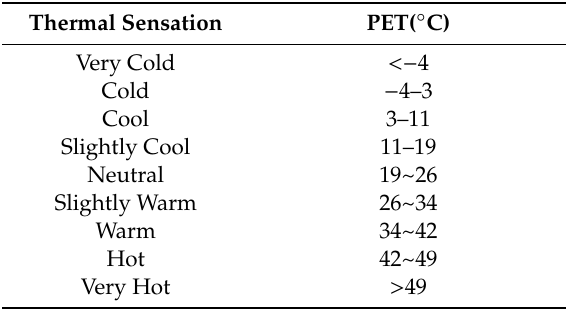
Table 6. The distribution of humans’ thermal sensation in hot-summer and cold-winter area [18]. PET = physiologically equivalent temperature. Thermal Sensation PET( ◦